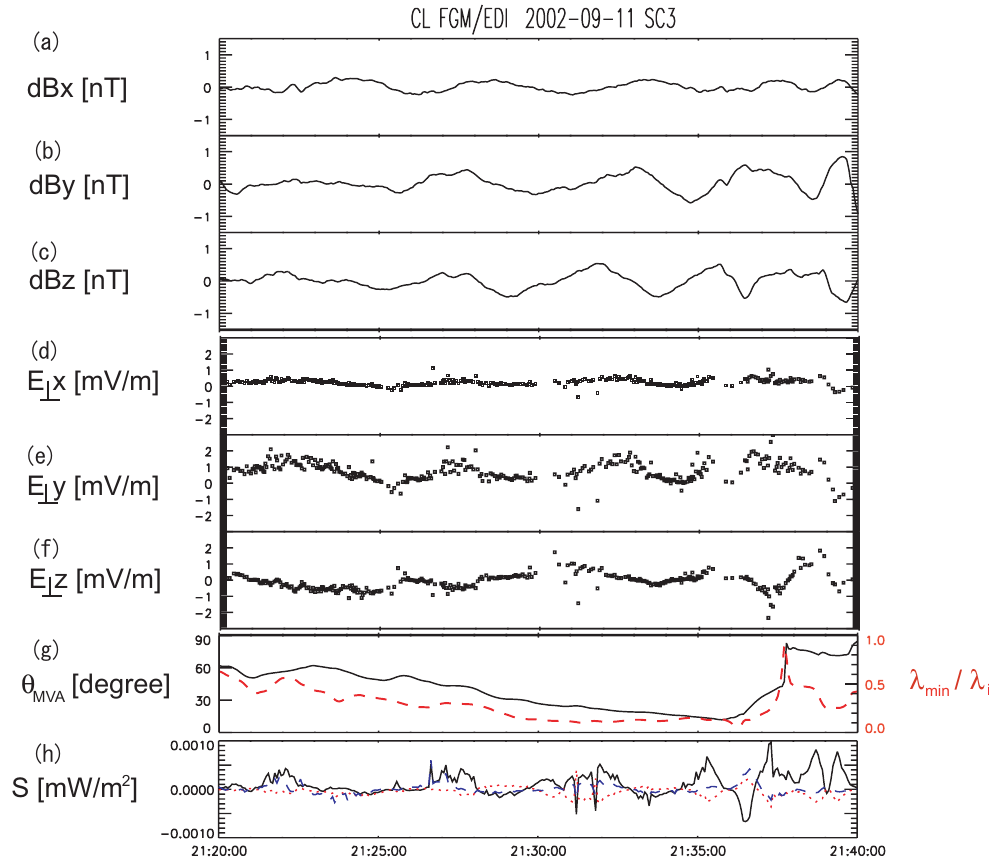
Fig. 2. Cluster SC 3 observation on 11 September 2002, of (a–c) three components of magnetic field after subtraction of the background magnetic field, B 0 (10 min moving average), and (d–f) three components of the perpendicular electric field. (g) The angle between the background magnetic field and the minimum variance axis (black solid), and the eigenvalue ratio of minimum and intermediate (red dashed) are shown. (h) Poynting flux ( Sx : black solid, Sy : red dotted, Sz : blue dashed) is calculated from the magnetic and electric fields fluctuations and is linearly-interpolated during the intervals when electric field data are